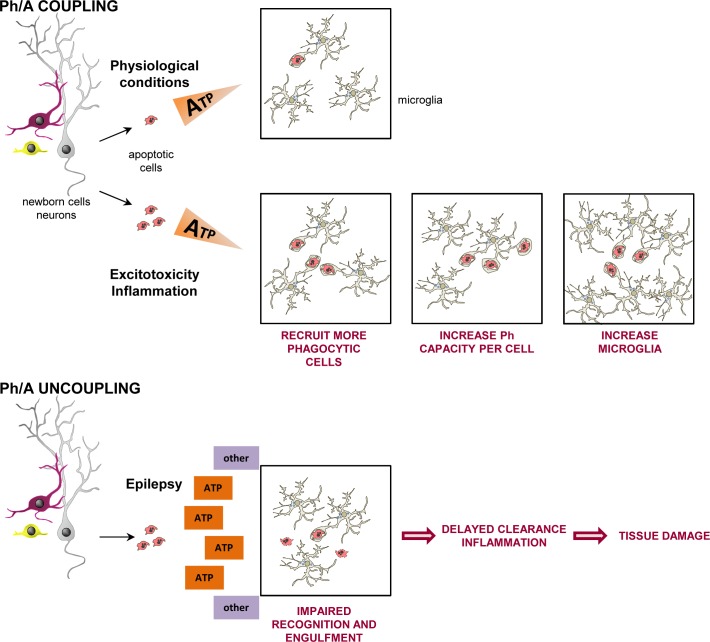
Microglial phagocytosis/apoptosis coupling in health and disease.In physiological conditions as well as during excitotoxicity and inflammation, microglial phagocytosis is tightly coupled to apoptosis due to “find-me” signals released by apoptotic cells, such as ATP. Microglia display a combination of three adaptation strategies to boost their phagocytic efficiency: recruit more phagocytic cells, increase the phagocytic capacity per cell, and/or increase the number of cells. In contrast, neuronal hyperactivity induced by seizures leads to a widespread release of ATP, among other possible signals, and interferes with the ability of microglia to recognize and engulf apoptotic cells, resulting in their delayed clearance. Because phagocytosis is actively anti-inflammatory, the phagocytosis impairment was associated with the production of proinflammatory, epileptogenic cytokines.